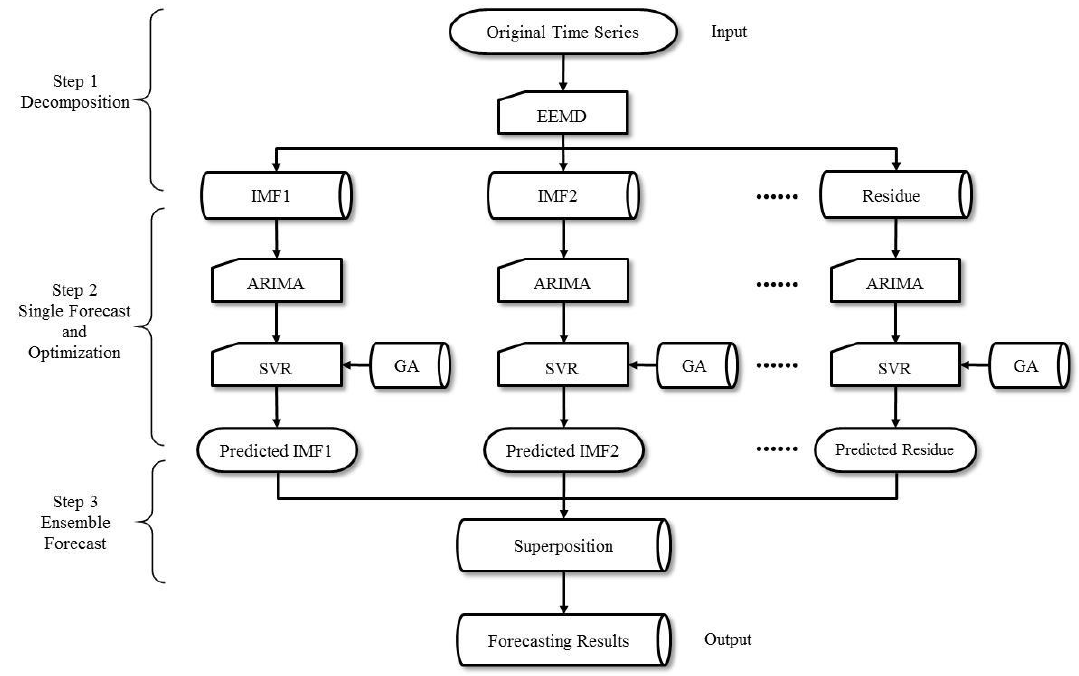
Figure 1. General procedure of the proposed ensemble empirical mode decomposition- autoregressive integrated moving average-genetic algorithm-support vector regression (EEMD)-(ARIMA)-(GA)-(SVR) modeling framework for primary energy consumption forecasting.